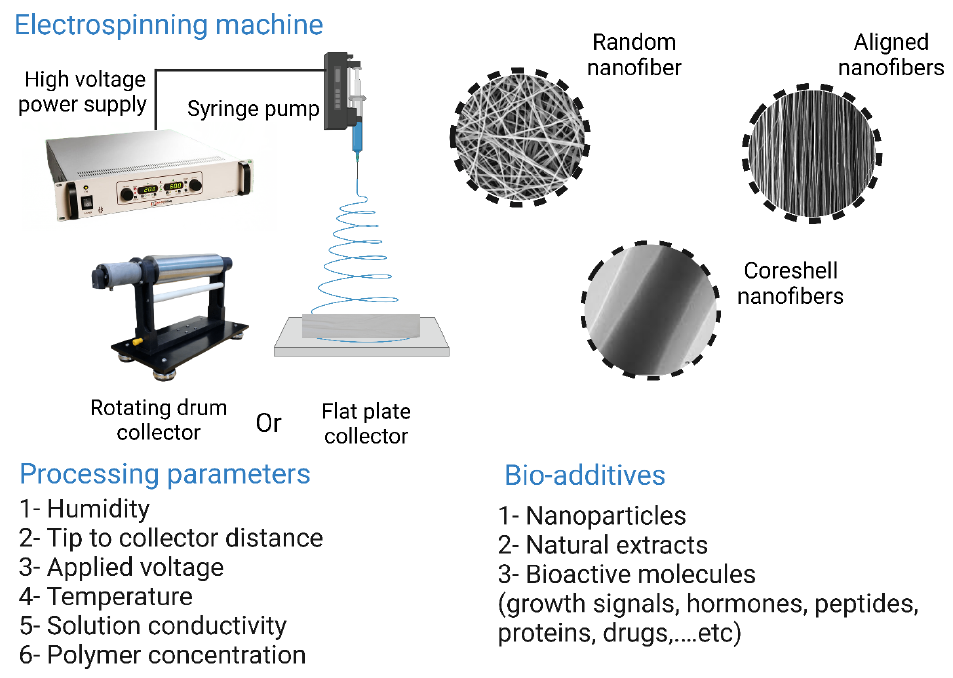
Figure 14. The electrospinning technique and its processing parameters, additives, and nanofiber types. The image was created using Biorender.